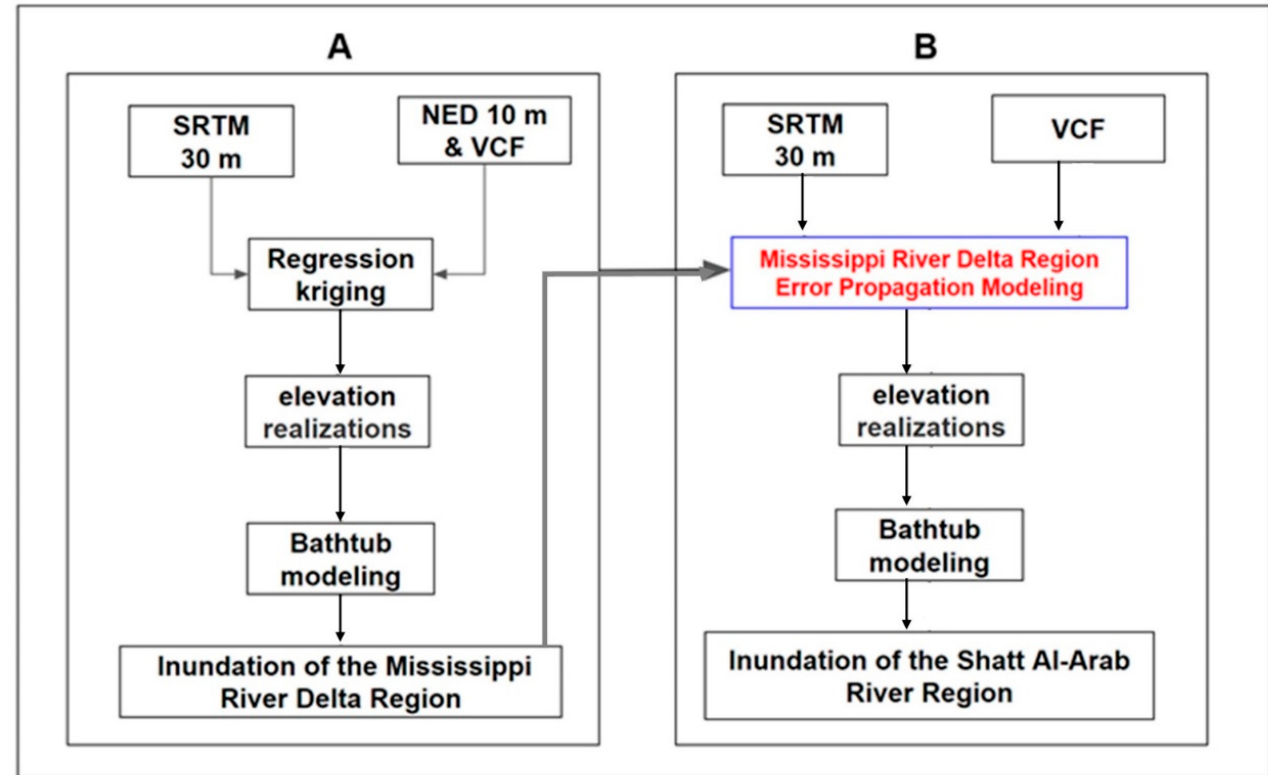
Figure 2. Transferring the error propagation model from the Mississippi River Delta region ( A ) to the Shatt Al-Arab River region ( B ).